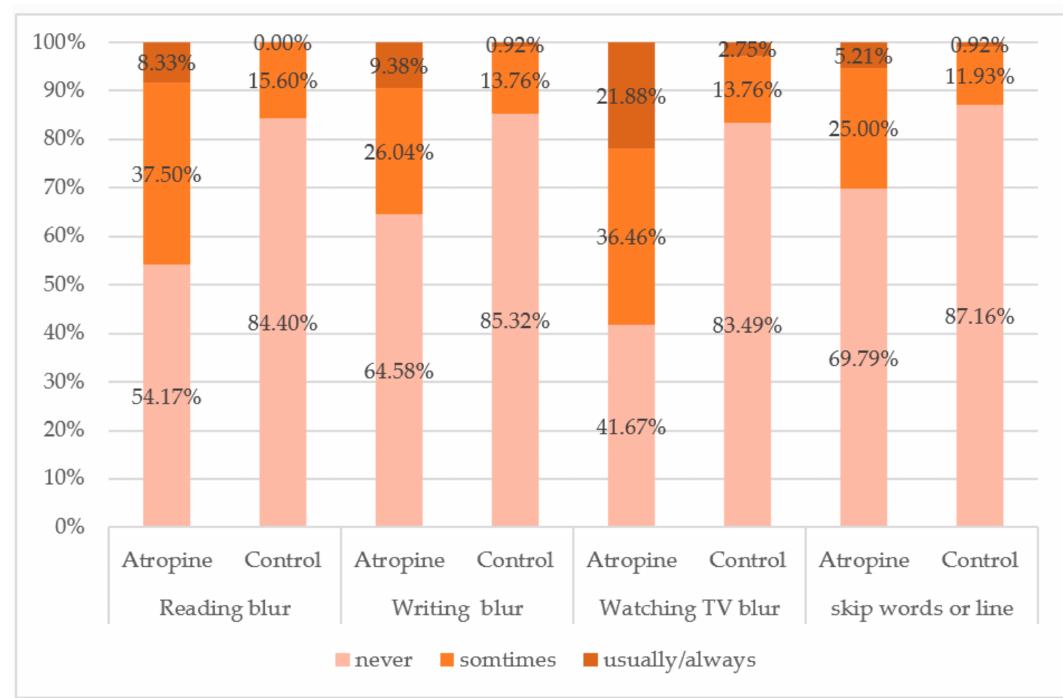
Figure 3. The frequencies of the four chief complaints regarding daily visual performance between the atropine and control